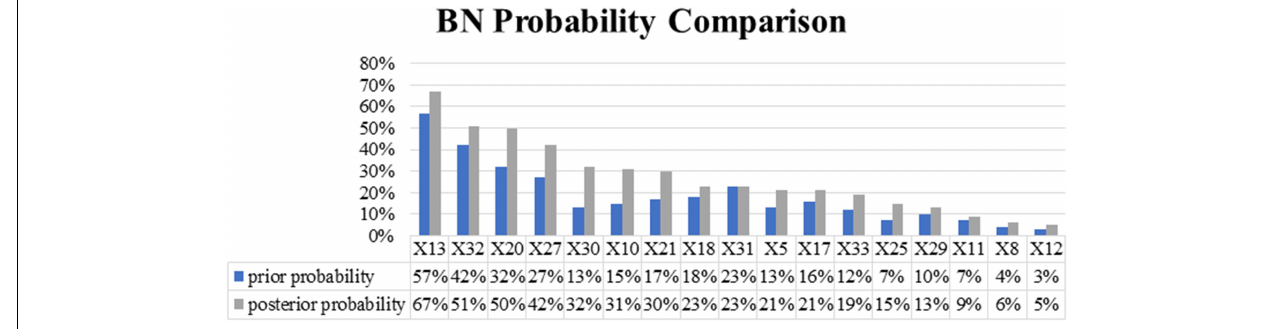
FIGURE 8 | Bayesian network probability comparison.